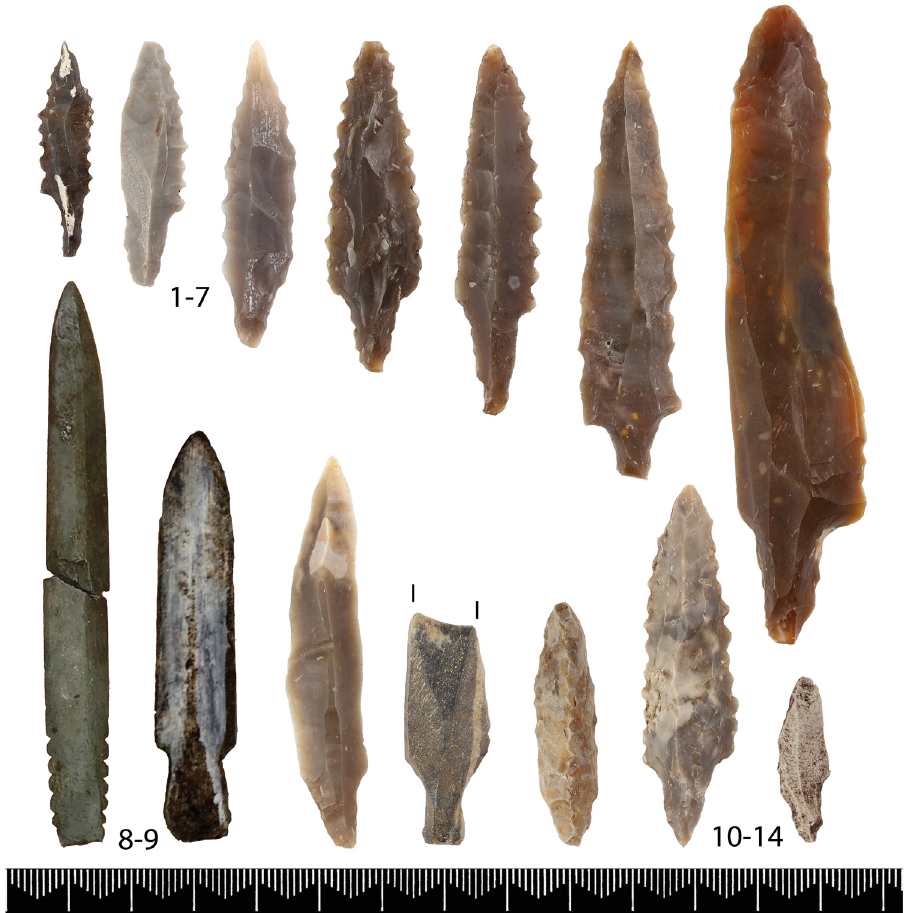
Figure 6: Selection of characteristic projectile points made from fl int ( 1 – 5, 10, 12 – 14 ) , rhyolite ( 11 ) and slate ( 8 and 9 ) ( C61487 ) . No. 3 and 5 have polished surfaces showing that they were made from polished fl int axes. Scale: millimeters.